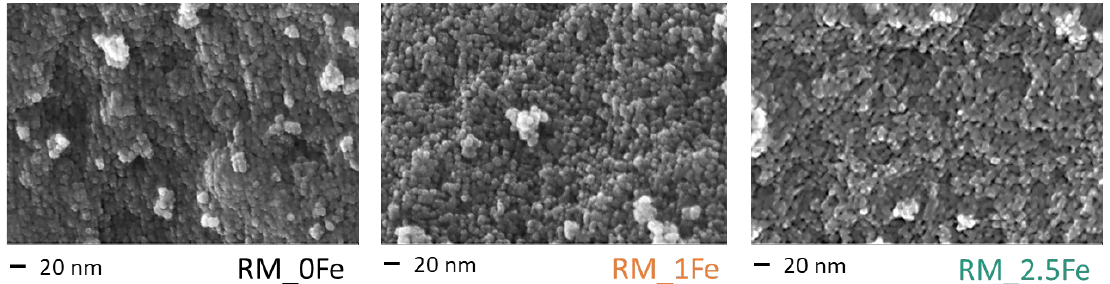
Figure 3. Selected FE-SEM micrographs as obtained with the RM_0Fe, RM_1Fe and the RM_2.5Fe powders, all showing similar morphology and degrees of agglomeration/aggregation.